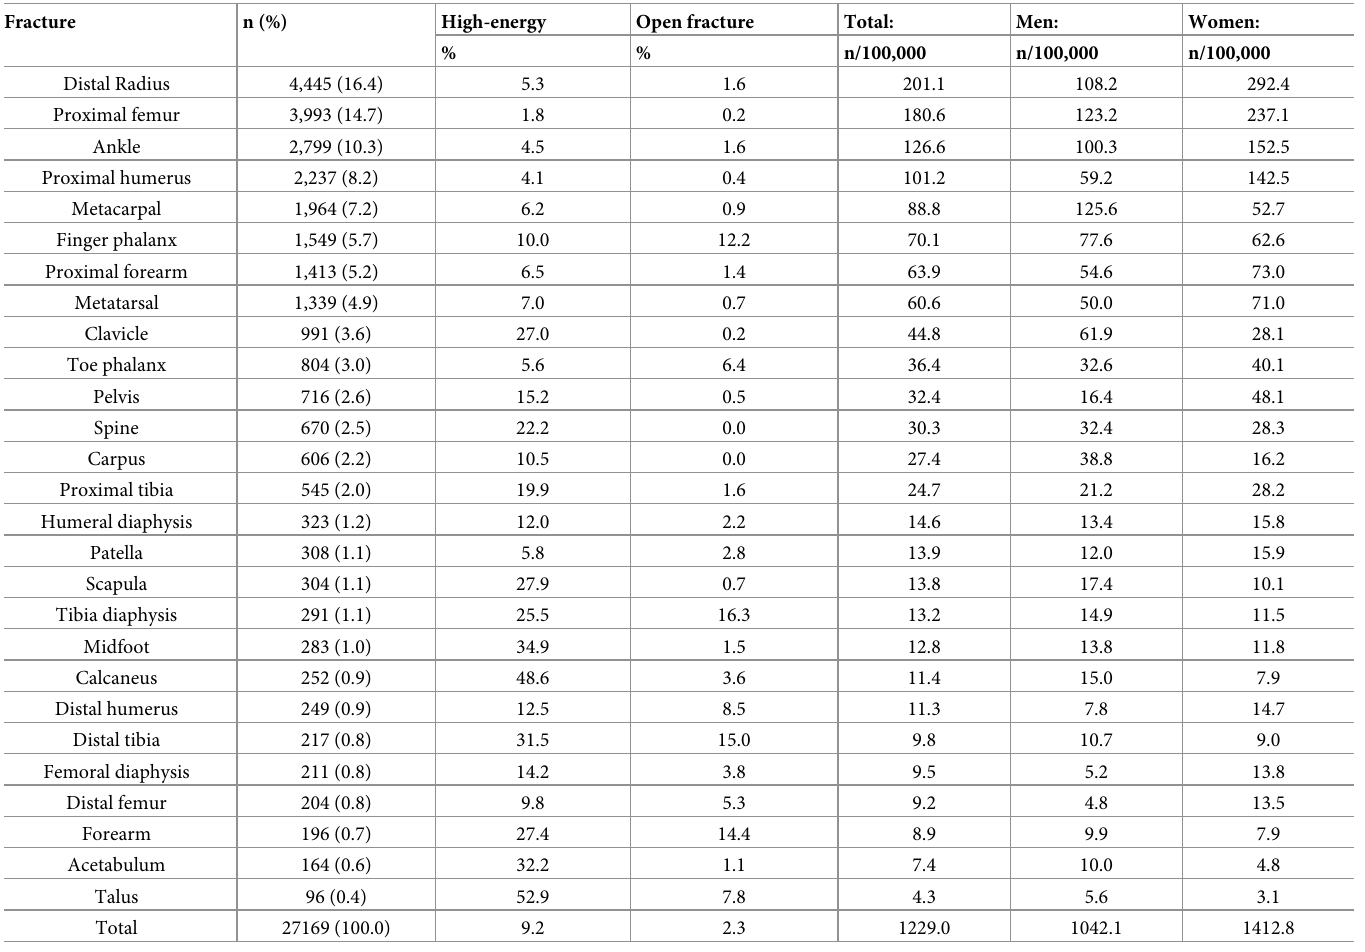
Table 2. Incidence of all fractures (2015–2018). Number of fractures sorted by location, proportion of fractures caused by high energy trauma, proportion of open frac- tures and incidence per 100,000 person-years (2015–2018) in total and by gender. Fractures arranged in order of decreasing incidence.